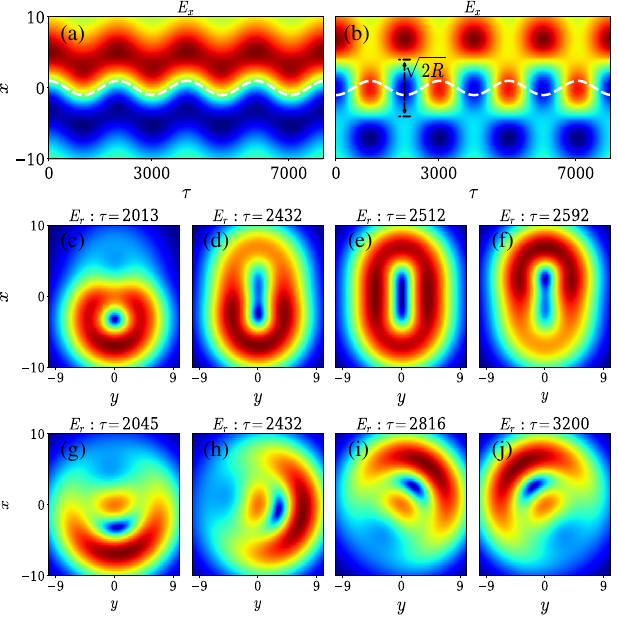
, x , generated by two r , r